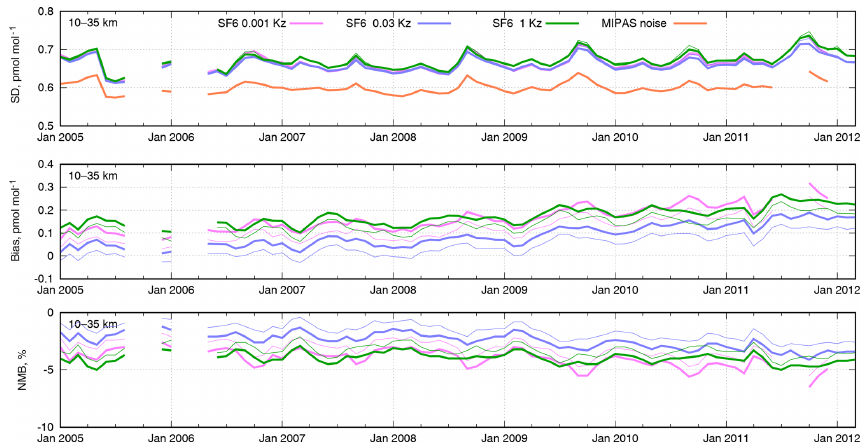
Figure 7. Time series of monthly scores for the SILAM SF 6 mixing ratios for the whole period of the MIPAS observations in the altitude range of 10–35km. The statistics are standard deviations of model–measurement difference (SD), absolute bias, and normalized mean bias (NMB). The statistics of the model mixing ratios extracted at nominal MIPAS altitudes are given as thin lines.